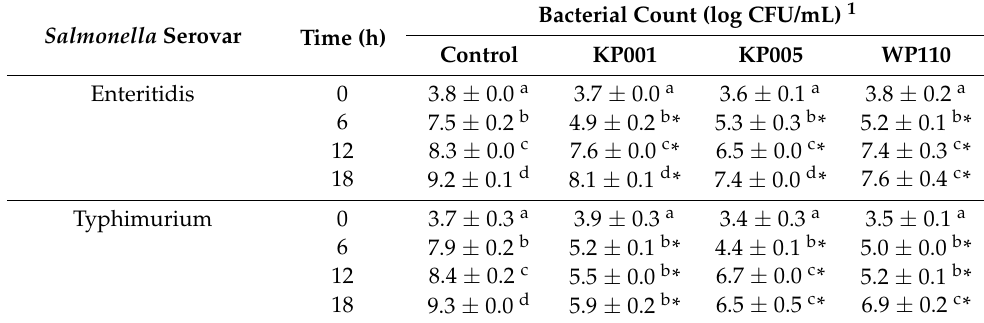
Table 2. The number of viable Salmonella counts when treated with individual phages.